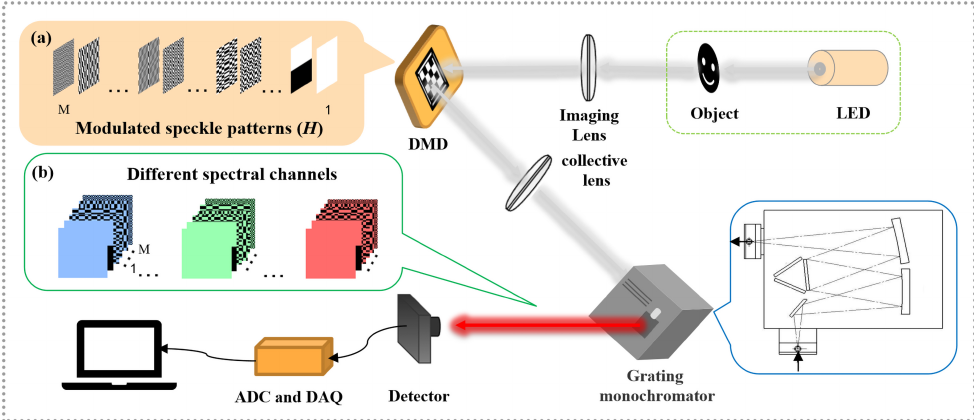
Figure 1. Diagram of experimental setup. ( a ) The modulated matrices H . ( b ) The different spec- tral